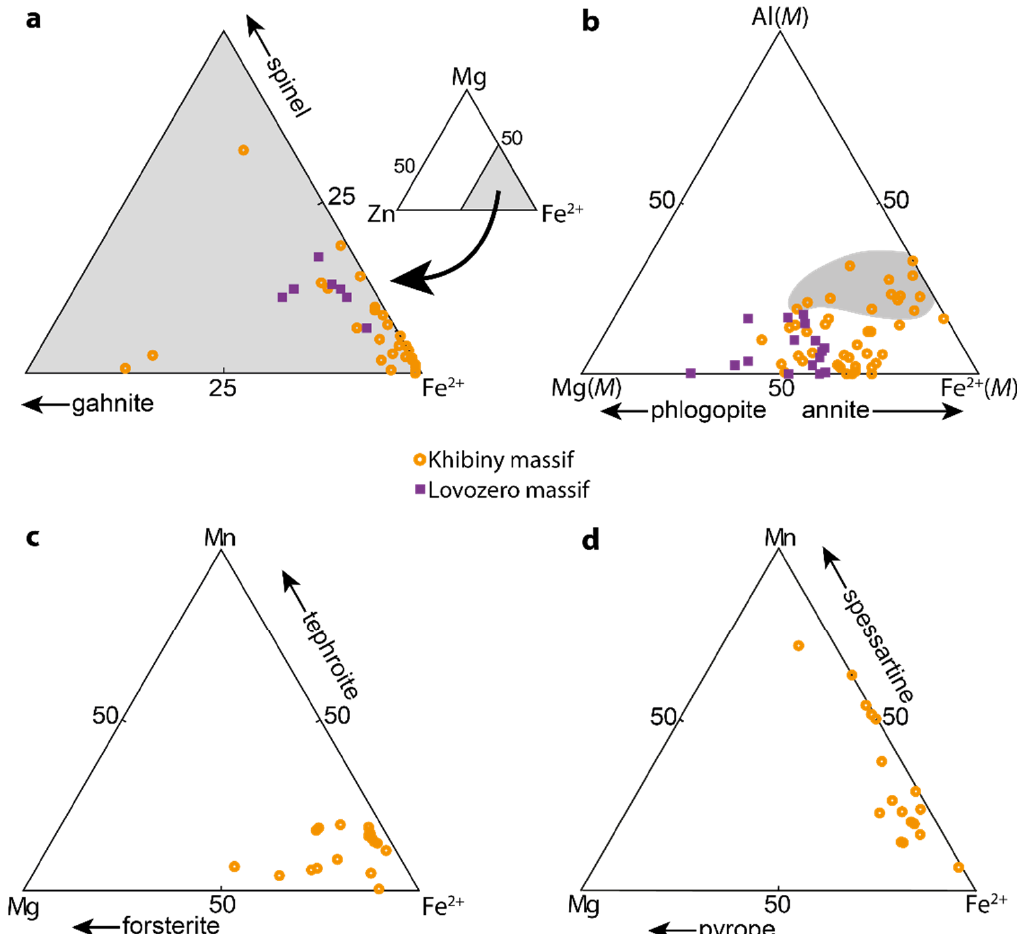
Figure 8. Compositions of rock-forming minerals from aluminous hornfelses. ( a ) Fe 2+ –Mg–Zn diagram showing the hercynite compositions; ( b ) diagram showing the ratio of cations in M site in the crystal structure of trioctahedral micas. General formula of micas I M 2-3 □ 1–0 T 4 O 10 A 2 [43]. The compositions corresponding to siderophyllite are shown on a gray background; ( c ) Fe 2+ –Mn–Mg diagram showing the fayalite compositions; ( d ) Fe 2+ –Mn–Mg diagram showing the garnet compositions.